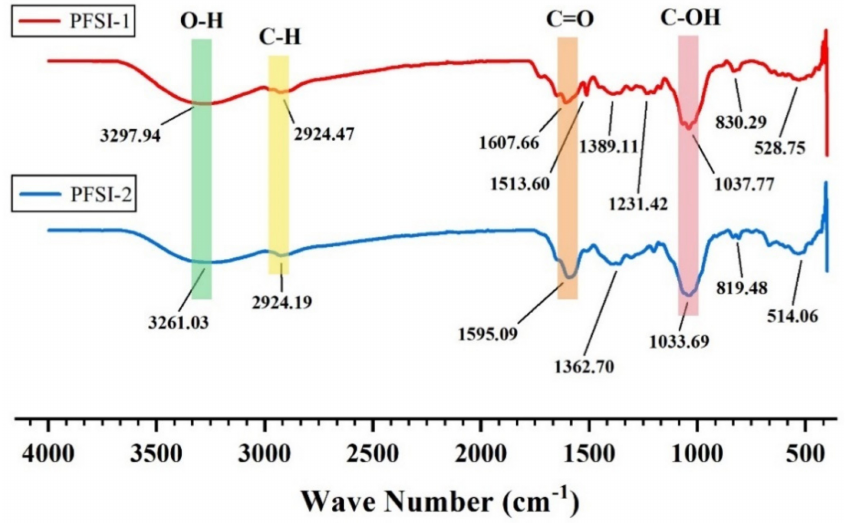
Figure 3. Infrared spectra of PFSI-1 and PFSI-2.